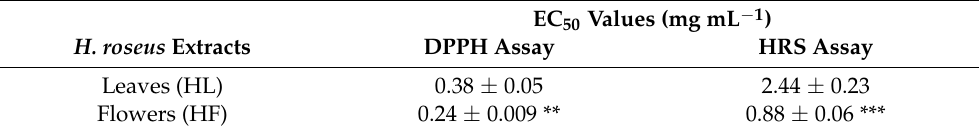
Table 3. Antioxidant activity (in terms of EC 50 ) of extracts of Hibiscus roseus leaves and flowers. EC 50 Values (mg mL − 1 ) H. roseus Extracts DPPH Assay HRS Assay Leaves (HL) 0.38 ± 0.05 2.44 ± 0.23 EC 50 values (in mg mL − 1 ) given in mean ± SD ( n = 3); *** p < 0.001; ** p < 0.01, comparison between flowers and